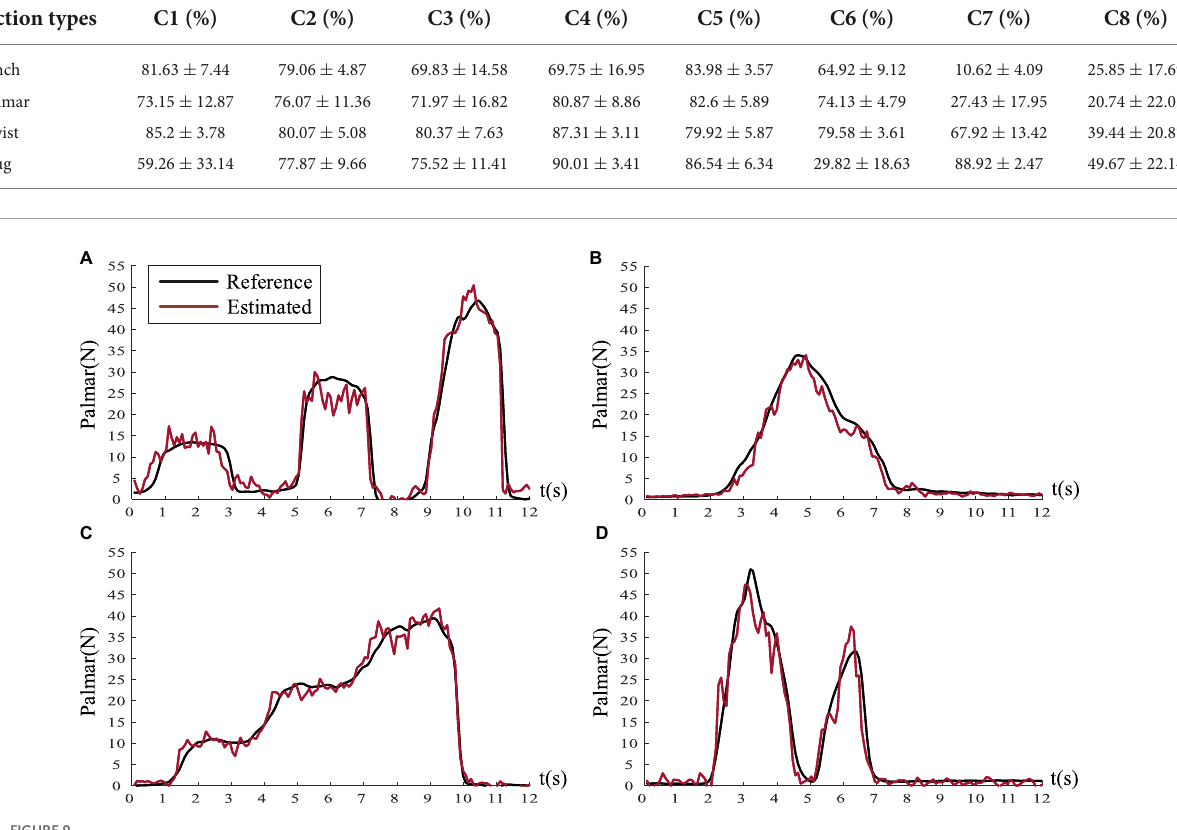
FIGURE9 The estimation result of palmar force under four profiles (Take subject five as an example). (A) A rectangular profile ( R 2 = 0.9375). (B) A triangle profile ( R 2 = 0.9751). (C) A step-climbing profile ( R 2 = 0.9832). (D) A random profile ( R 2 =